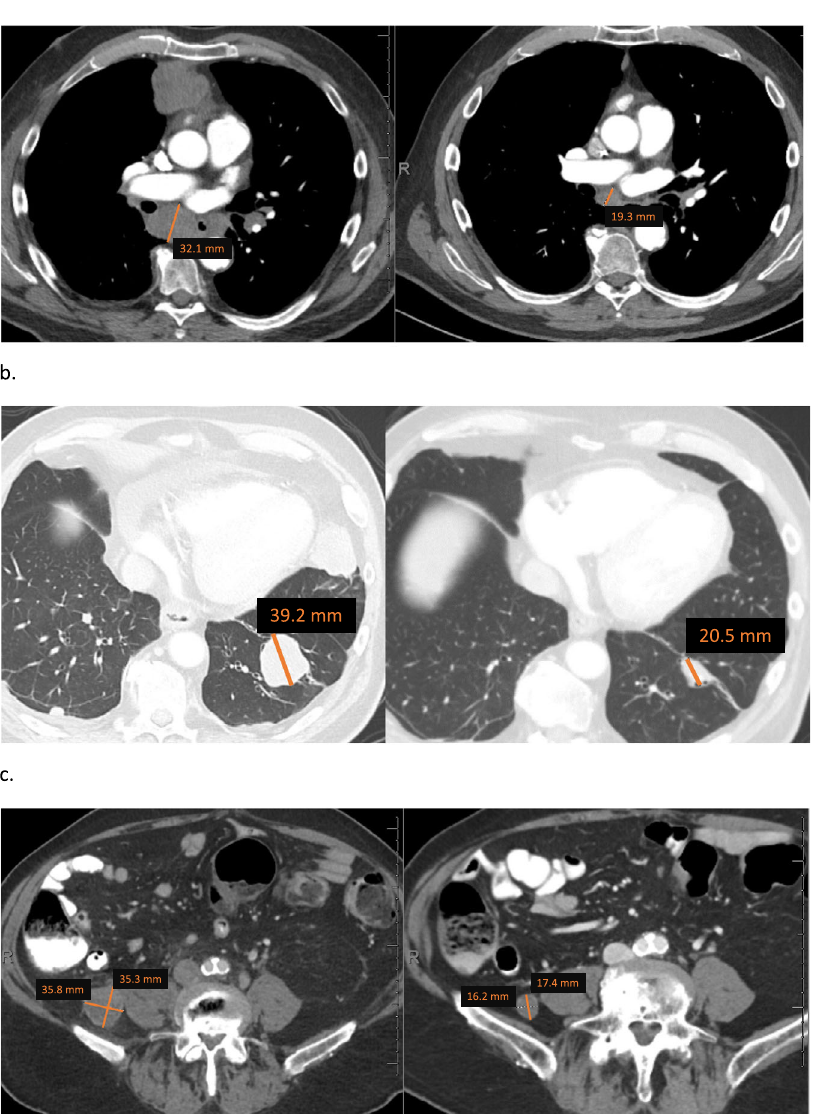
Fig. 2 Representative sections of computerized tomography in patient #22 with unclassi fi ed renal cell carcinoma harboring EWSR1- POU5F1 fusion t(6;22)(p21;q12). Panels ( a ), ( b ), ( c ) show partial response per RECIST version 1.1 in mediastinal adenopathy ( a ), lung metastasis ( b ) and pelvic adenopathy ( c ) in Left and right panels re fl ect baseline and nadir after therapy,